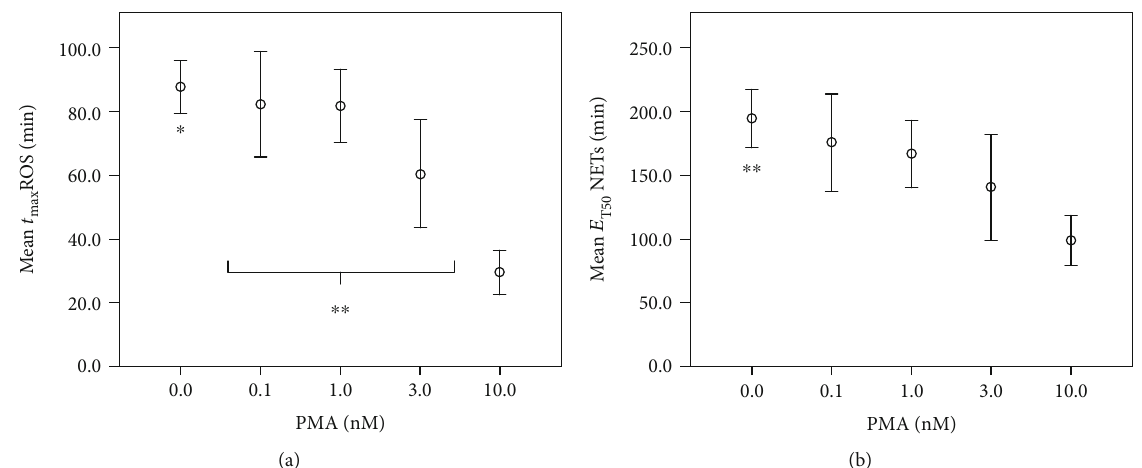
Figure 3: Point of time of ROS production and half-maximal NET formation decrease during PMA exposition. x -axis: PMA (nM) concentration in nM; y -axis: (a) mean time of maximal ROS formation t max ROS (min) in min; (b) mean time of half-maximal NET NETs in minutes; ∗ signi fi cant compared to 3nM and 10nM PMA; ∗∗ signi fi cant ( P < 0 : 05 ) compared to 10nM PMA; error formation E T50 bars represent standard deviation of